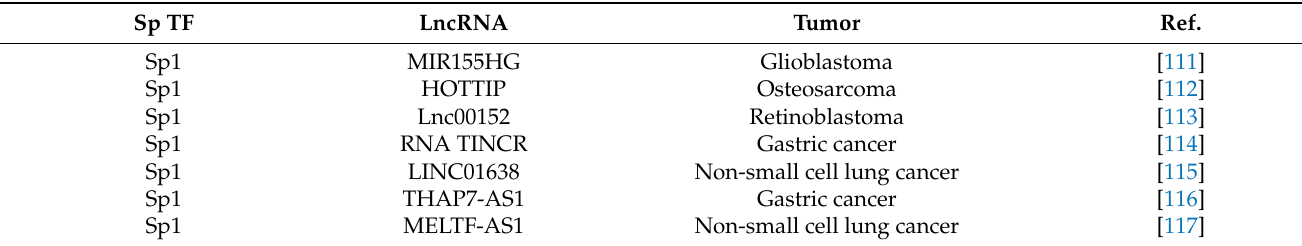
Table 3. Sp TFs regulate LncRNA expression in cancer